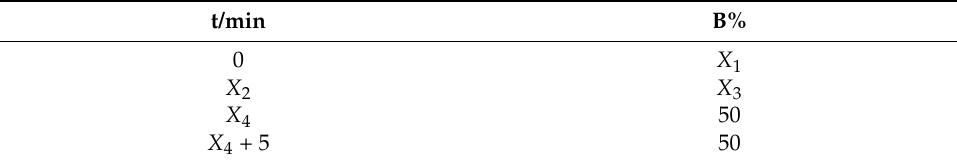
Table 1. HPLC gradient conditions.